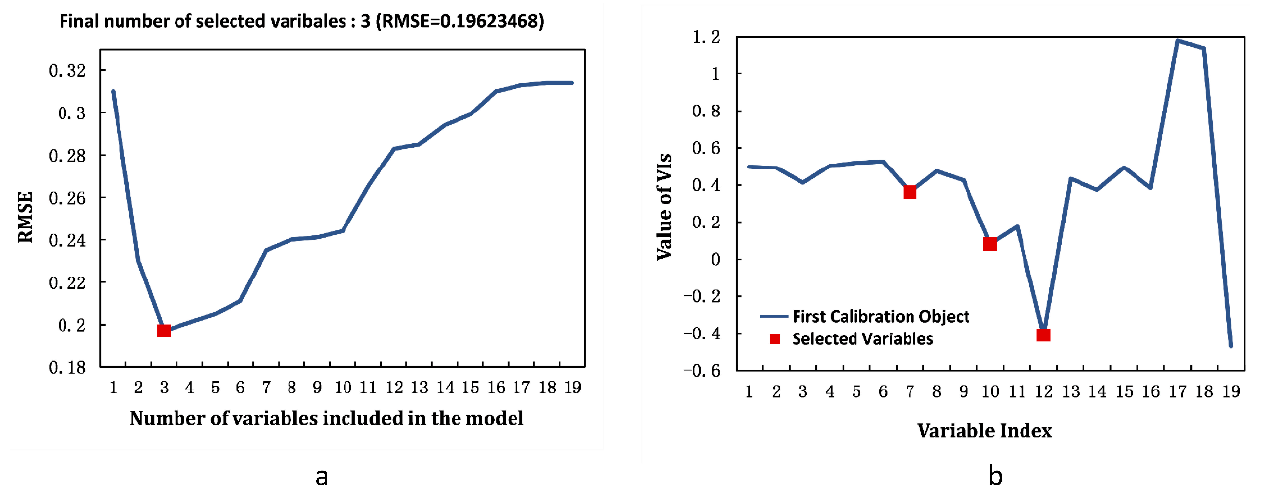
Figure 9. Process of variable extraction by SPA. ( a ) The variation of RMSE. ( b ) The selection of optimal variables (the value of VIs is the size of the actual value of the vegetation index, and the Variable Index is the number of vegetation indices entered into the algorithm).